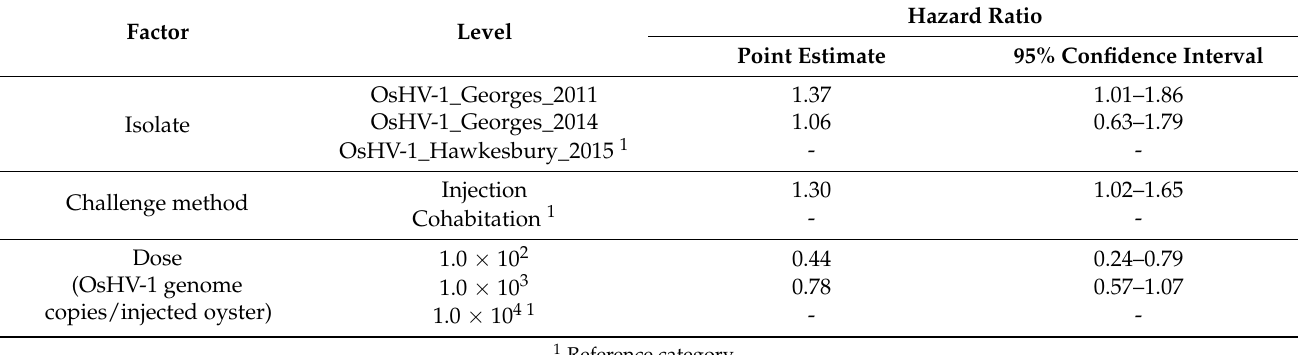
Table 3. Hazard ratios predicted from a Cox proportional hazards model.